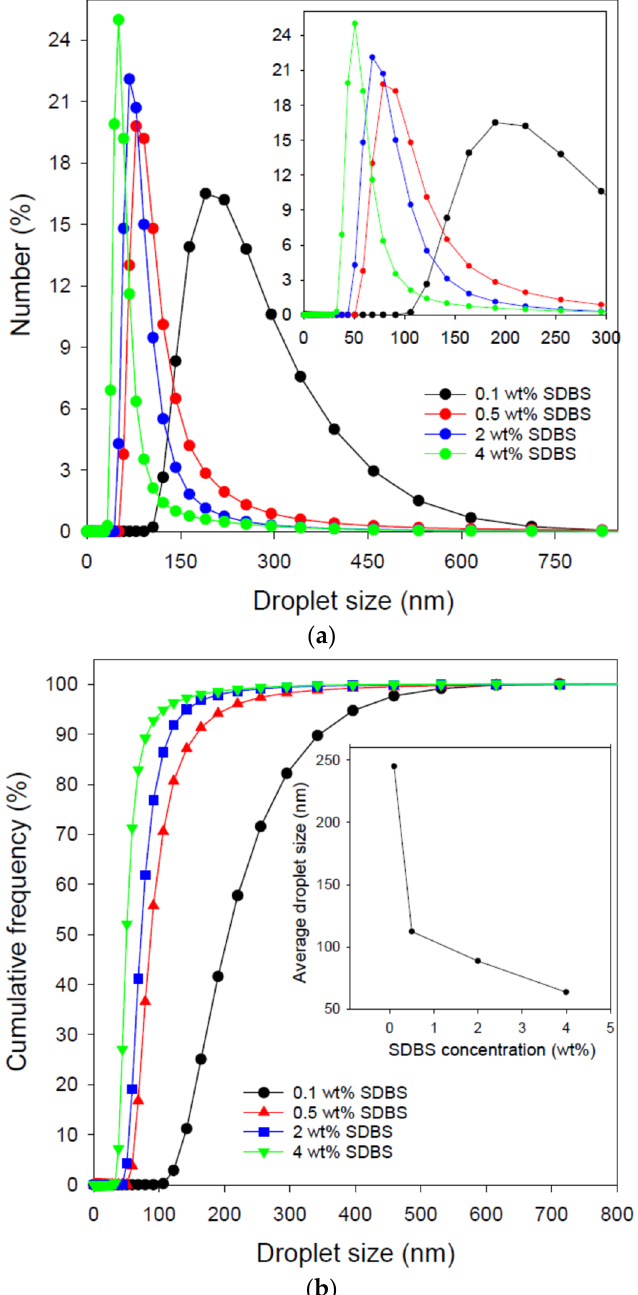
Figure 1. ( a ): Effect of SDBS concentration on the droplet size distribution of the formulated crude oil/water nanoemulsions. The inset shows the droplet size distribution up to 300 nm. ( b ): Effect of SDBS concentration on the cumulative frequency of droplet size. The inset shows the average droplet size at different SDBS concentrations .